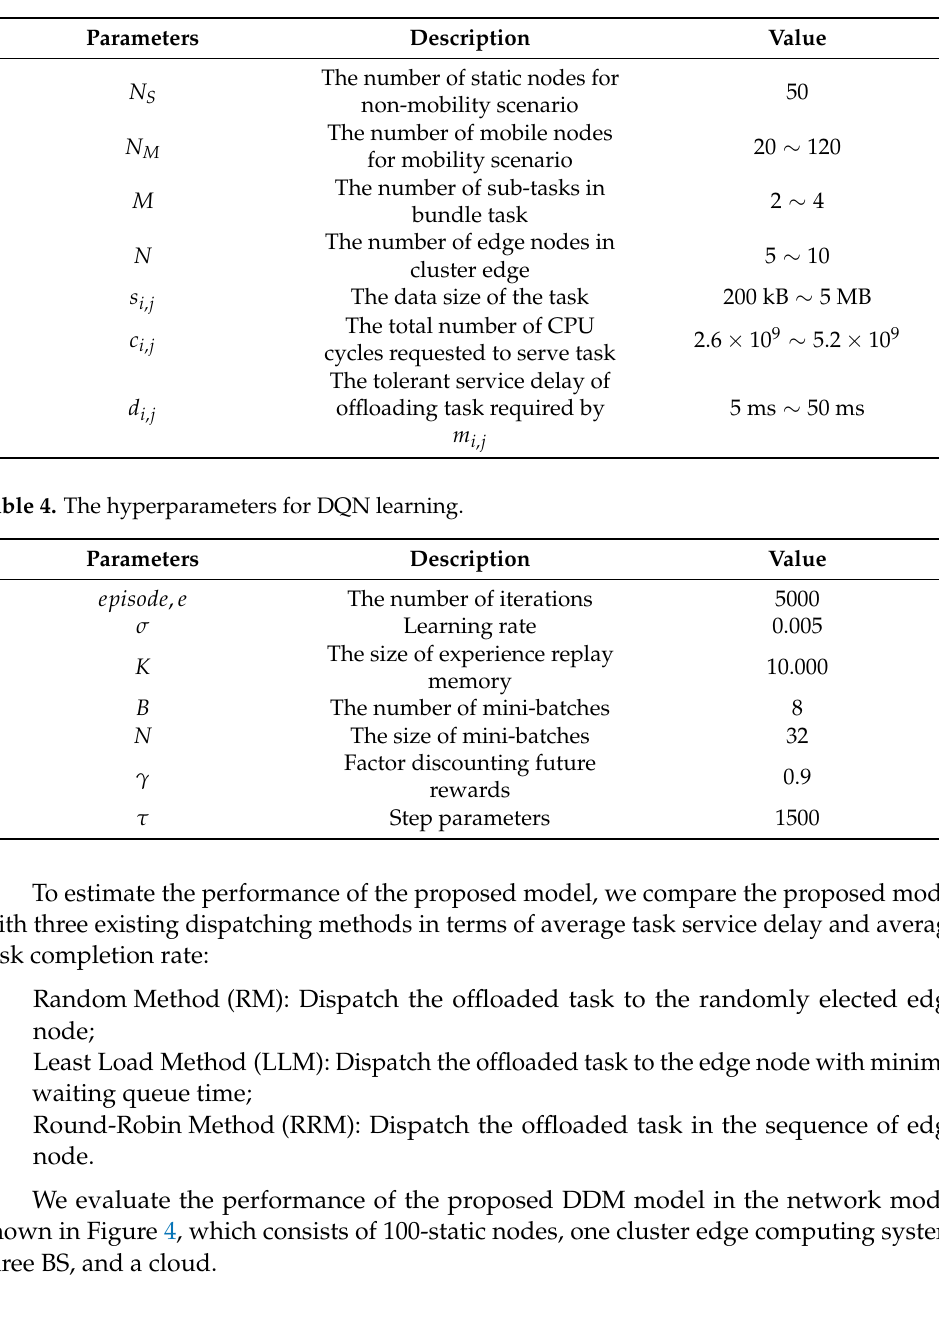
Table 3. Main simulation parameters for the environment.